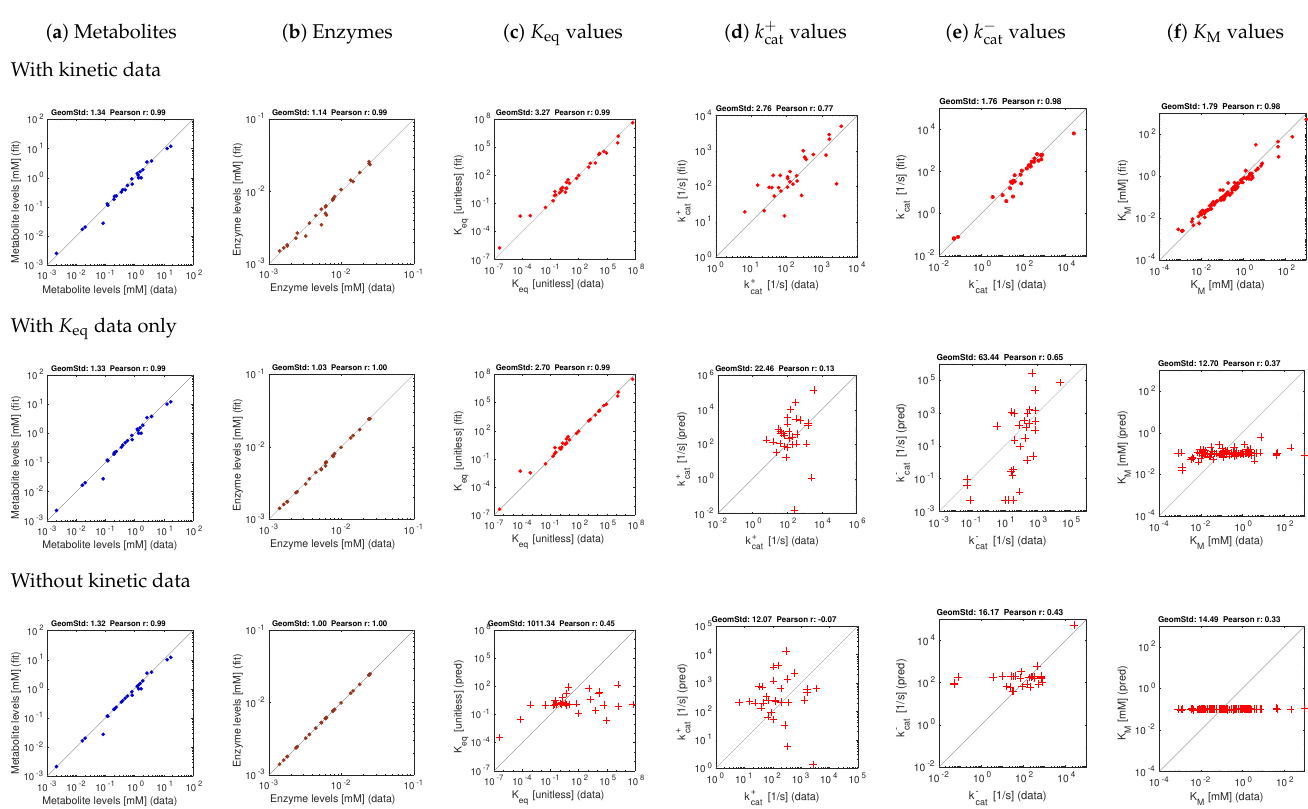
Figure 5. Results for E. coli central metabolism with experimental data (aerobic growth on glucose). The kinetic data stem from previous parameter balancing based on in-vitro data. Top : estimation using kinetic data. Centre : model fit using equilibrium constants as data. Bottom : estimation without usage of kinetic data. Metabolite, enzyme, and kinetic data were taken from [43]. A stringency parameter α = 0.5 was used. The fact that our kinetic data were obtained from parameter balancing, based on the same network model and the same priors, leads to a bias. However, a test with original in-vitro kinetic data (and thus fewer data points, not shown) yielded similar results. Predicted kinetic constants may be validated by cross-validation; the results can be expected to lie in between the results from our “fitting” (dots) and “prediction” scenarios